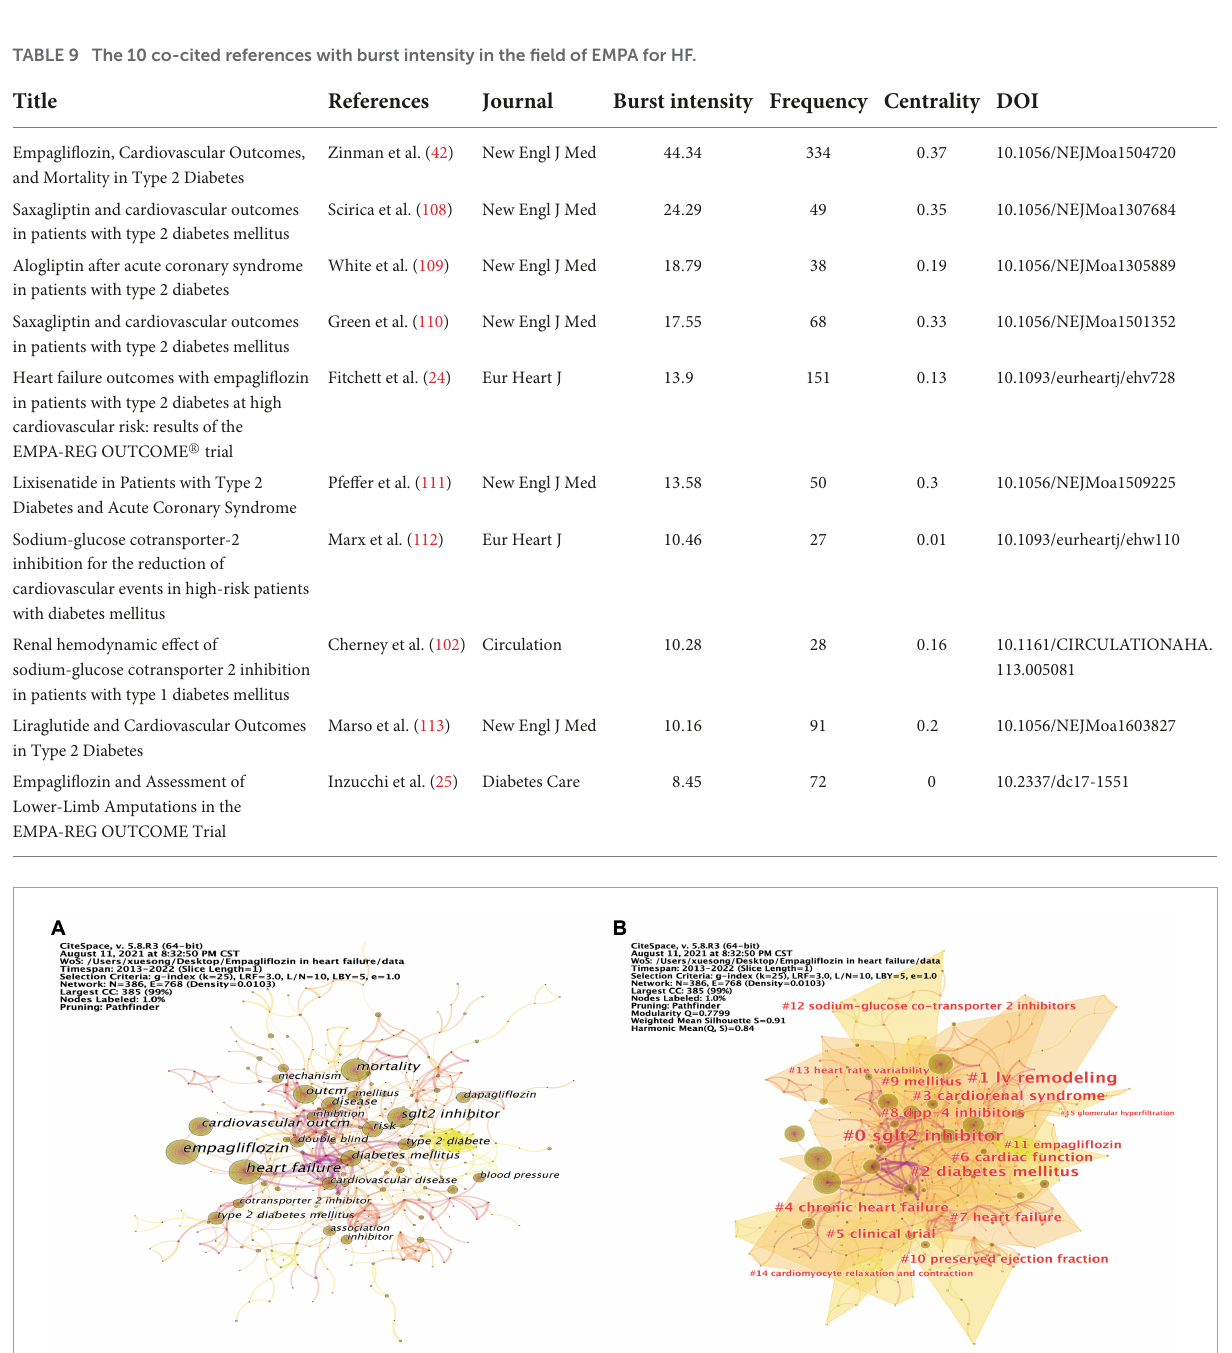
FIGURE5 Keywords analysis and visualization. (A) The occurrence of keywords. (B) The cluster of